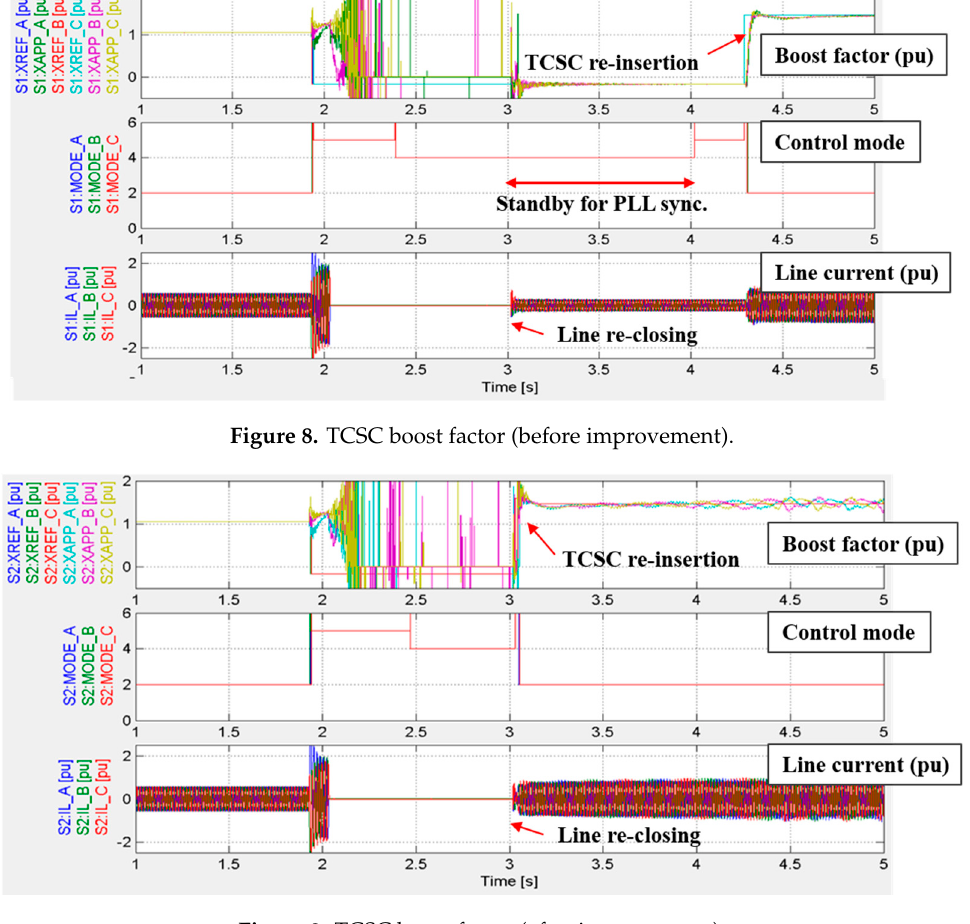
Figure 9. TCSC boost factor (after improvement).